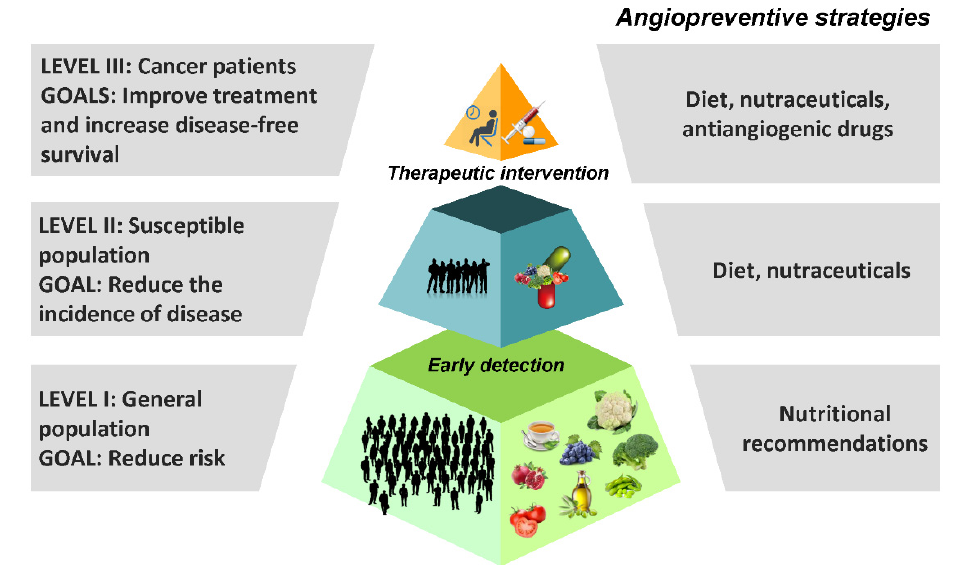
Figure 4. Different angiopreventive strategies can be implemented, depending on the targeted pop- ulation.